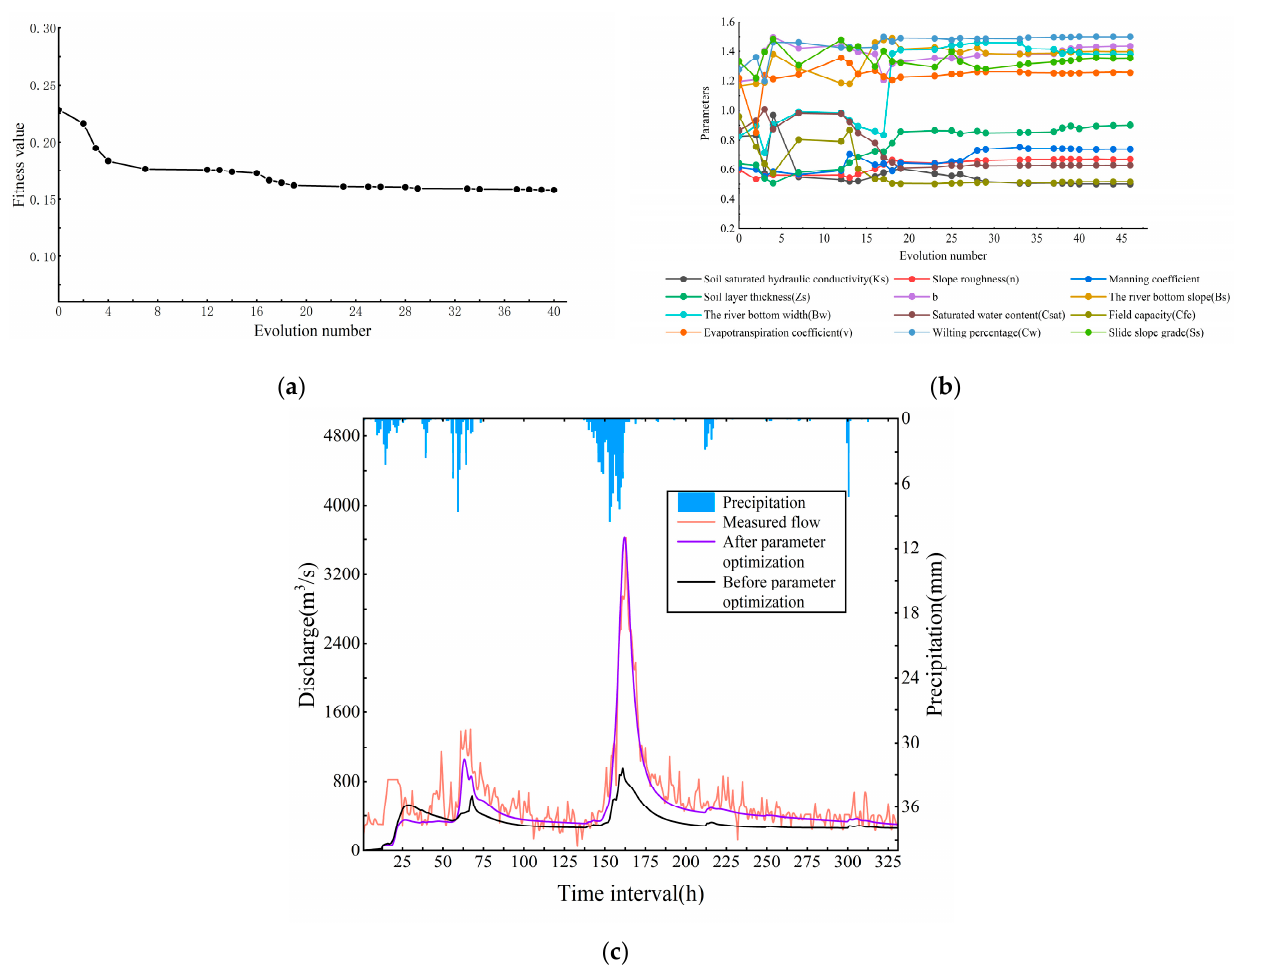
Figure 4. Results of the parameter optimization of the Liuxihe model with the PSO algorithm. ( a ) The changing curve of the objective function; ( b ) the parameter evolution process; and ( c ) the simulated hydrographs before and after parameter optimization.